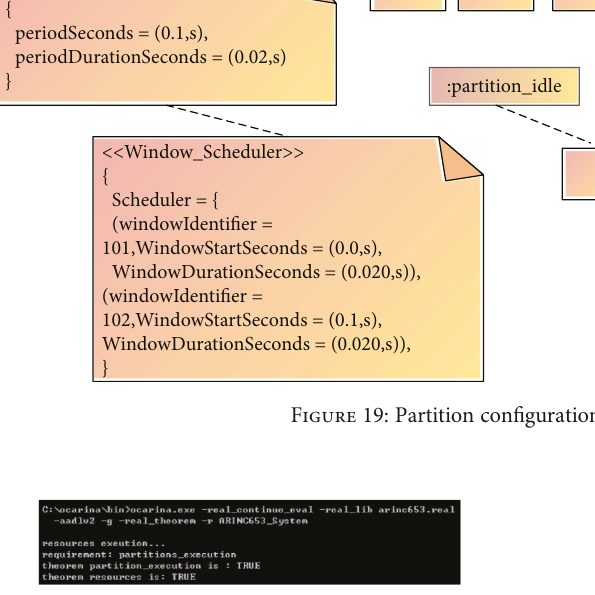
Figure 20: Result of partition con fi guration analysis. Table 14: Recon fi guration table of partition